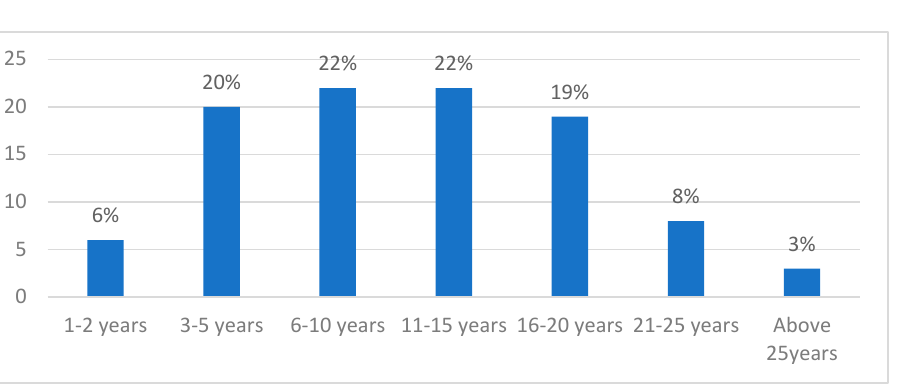
Figure 4. Respondents’ educational qualification. 4.2. Results from the Exploratory Factor Analysis 4.2.1. KMO and Bartlett’s Test Table 2 presents the result of EFA measures of data sample adequacy using Kaiser– Meyer–Olkin (KMO) and Bartlett’s test of sphericity. The KMO returned a value of 0.826 more than the 0.6 set as minimum criteria, and Bartlett’s test returned a significant value of 0.000 below 0.5 as benchmarked data suitability for factor analysis [59]. Table 2. KMO and Bartlett’s Test. KMO and Bartlett’s Test Kaiser – Meyer – Olkin Measure of Sampling Adequacy